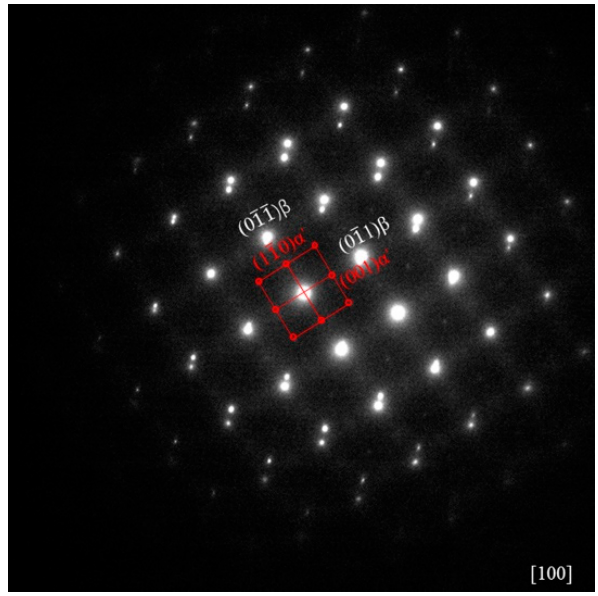
Figure 4. β and α ’ martensite phase selected area electron diffraction (SAED) patterns of the Zr-16Nb-xTi alloys.